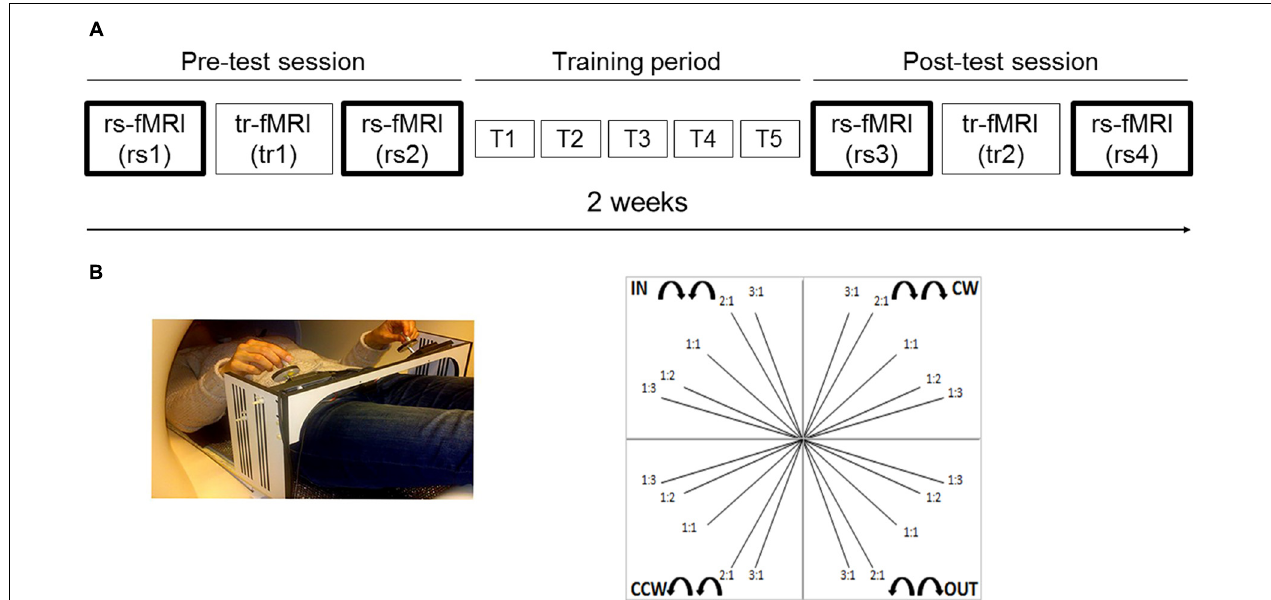
FIGURE 1 | Experimental setup and task. (A) Schematic representation of the experimental setup. Two scan sessions occurred before (pre-test session) and after (post-test session) five training sessions (training period), distributed across 2 weeks. Each scan session included a rest scan (rs1 and rs3, respectively) before a task-related scan, a task-related scan (tr1 and tr2, respectively) and a rest scan after the task-related scan (rs2 and rs4, respectively). We mainly focused on rest scans (i.e., two runs within each scan session, four runs in total: rs1, rs2, rs3, and rs4); (B) The goal of the bimanual tracking task was to track a white target dot over a blue target line, presented on a screen, by rotating two dials with both hands simultaneously in one of four directional patterns: inward (IN), outward (OUT), clockwise (CW), and counter-clockwise manner (CCW); at five different relative frequency ratios: 1:1, 1:2, 1:3, 2:1, and 3:1 (left: right). This resulted in 20 different bimanual patterns and target line